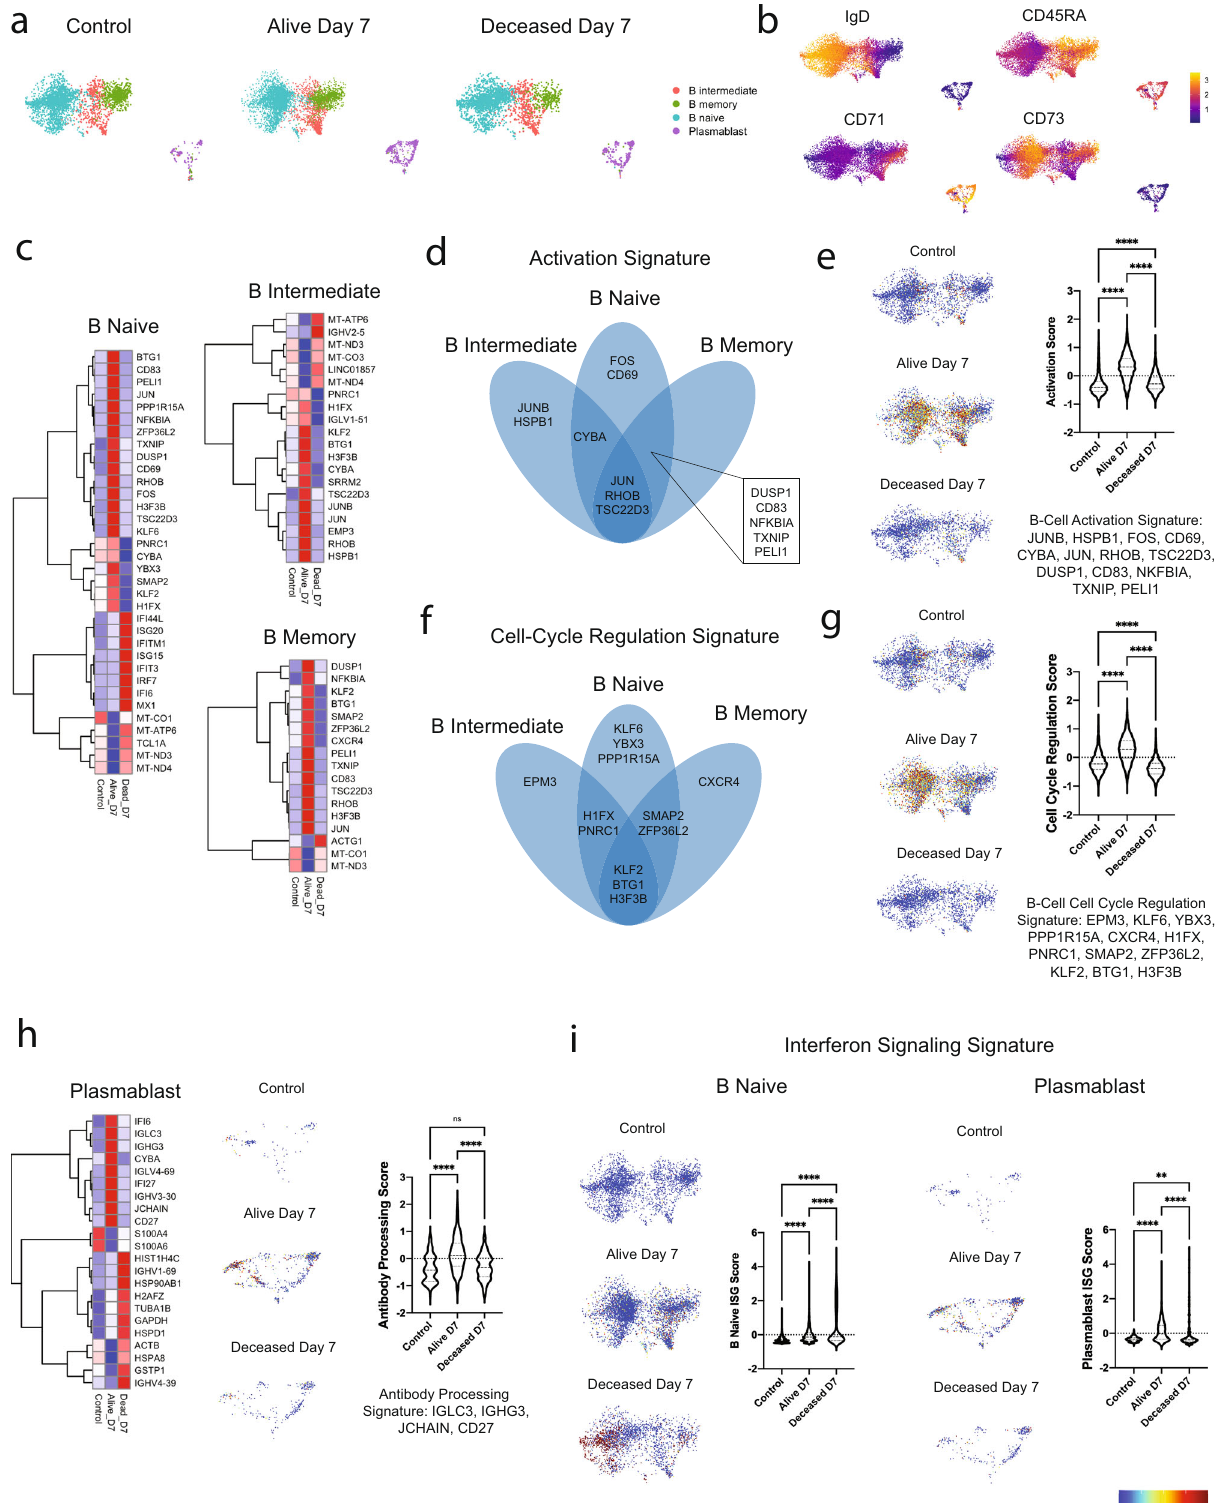
displayed signatures of antigen-presentation and interferon signaling in patients who survived relative to controls and the deceased cohort. CD16 monocytes also displayed signatures of cell activation and antigen-presentation selectively in surviv- ing patients whereas interferon signaling was increased in both patients who survived and died compared to controls